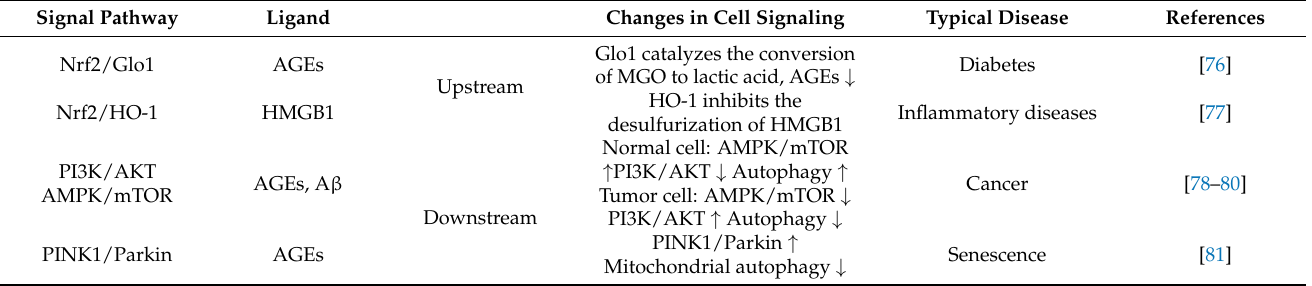
Table 2. Regulatory mechanisms of other RAGE-related signaling pathways and typical diseases